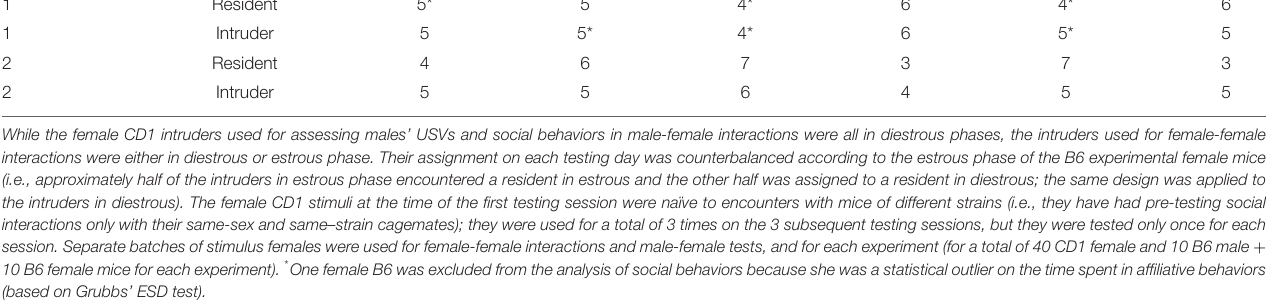
TABLE 1 | Estrous phase of the resident B6 female mice and the CD1 stimulus female intruders for each testing session. Experiment Estrous phase Session 1 Session 2